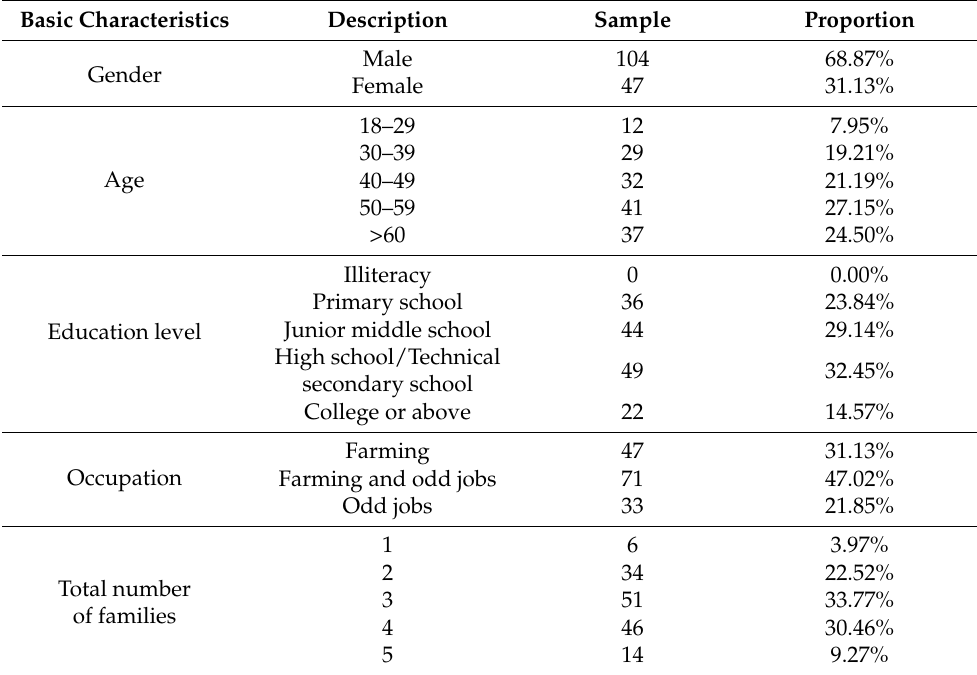
Table 6. Basic characteristics of individuals and families of the surveyed